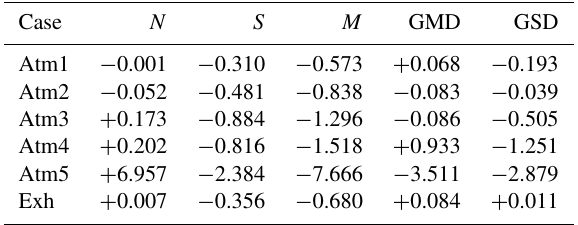
Table 2. Relative errors, δ X (%), of the variables at the ends of the test case simulations using the PL + LN model compared to the variables produced by the fixed-sectional model with 1000 size sec- tions. The input parameter sets are shown in Table 1. N , S , and M are the number, the surface area, and the mass concentration of the total particle distribution, respectively. GMD and GSD are the ge- ometric mean diameter and the geometric standard deviation of the